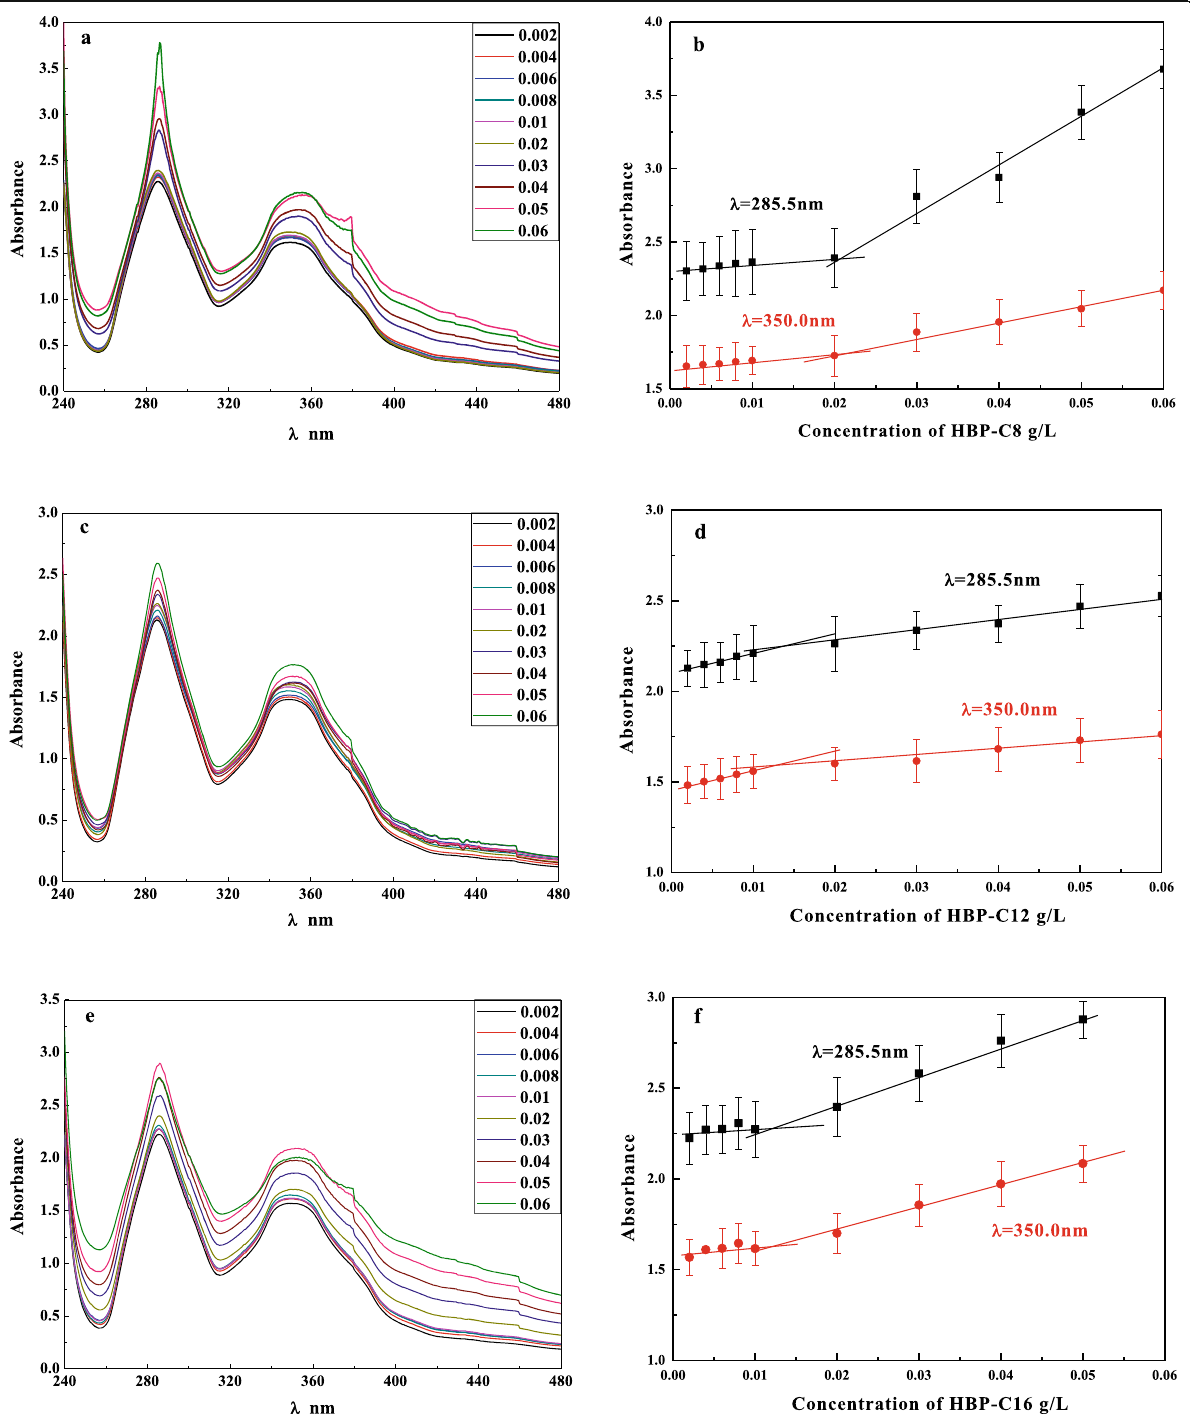
Fig. 8 The ultraviolet absorption spectra of HBP-C8 ( a, b ), HBP-C12 ( c, d ) and HBP-C16 ( e, f ) with different